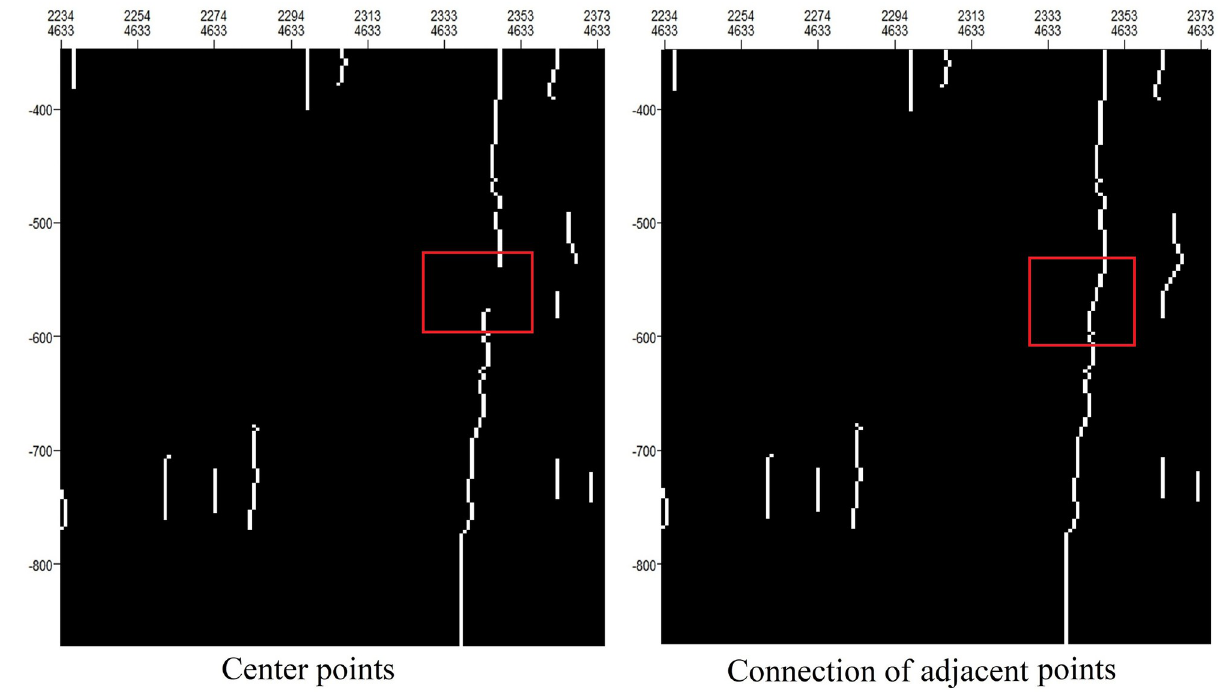
Fig 6. Connection of adjacent